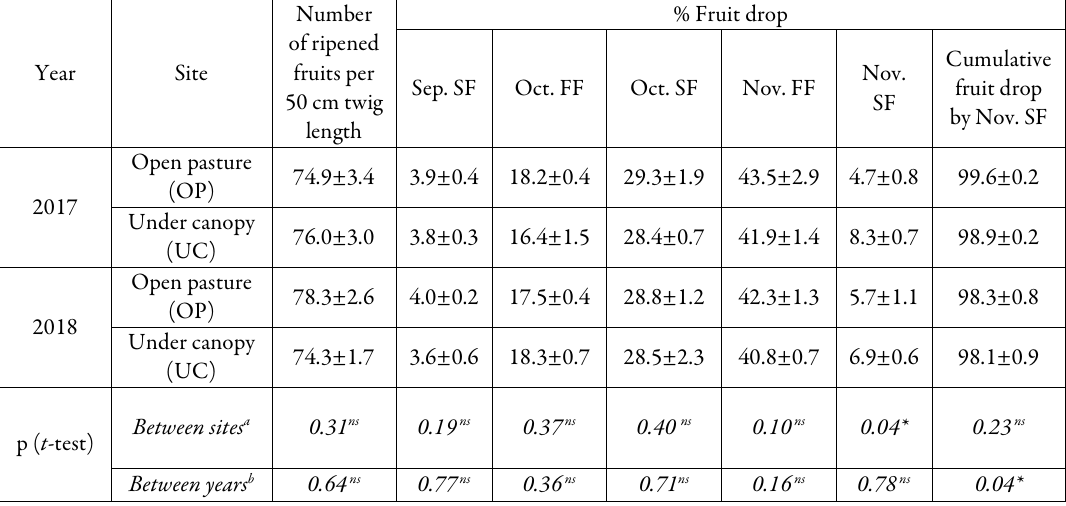
Table 2. Fruit set and drop pattern of P. crenulata in two sites during two consecutive years